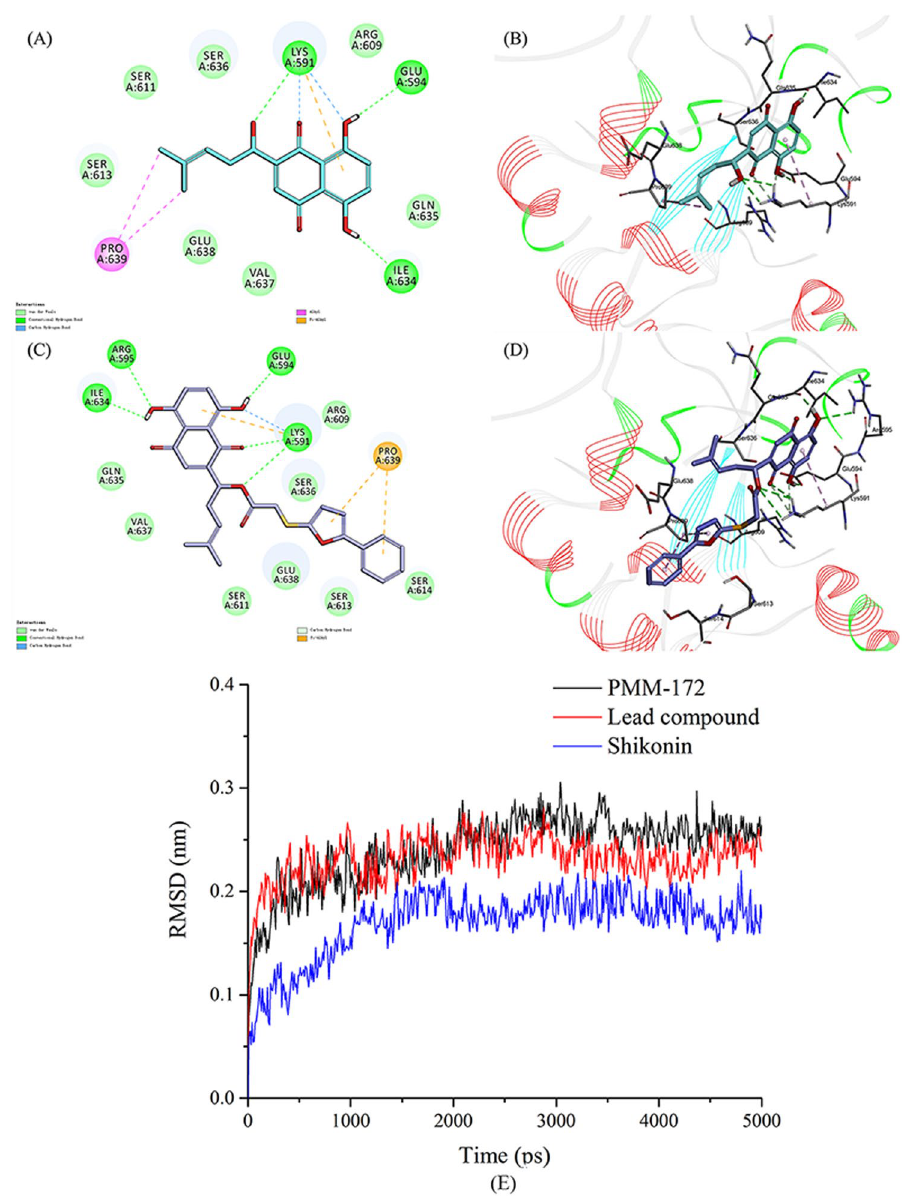
Figure 2. Binding mode of SHK and lead compound PMM-158 with STAT3 (PDB code: 1BG1). ( A ) 2D diagram of the interaction between SHK and amino acid residues of the nearby active site. ( B ) 3D diagram of SHK inserted in the STAT3 binding site: for clarity, 3D structure of the protein is presented in line ribbon and only interacting residues are displayed. ( C ) 2D diagram of the interaction between PMM-158 and amino acid residues of the nearby active site. ( D ) 3D diagram of PMM-158 inserted in the STAT3 binding site: for clarity, 3D structure of the protein is presented in line ribbon and only interacting residues are displayed. ( E )The RMSDs of the three studied complexes obtained during 5 ns of MD simulations, SHK (blue), lead compound (red) and PMM-172